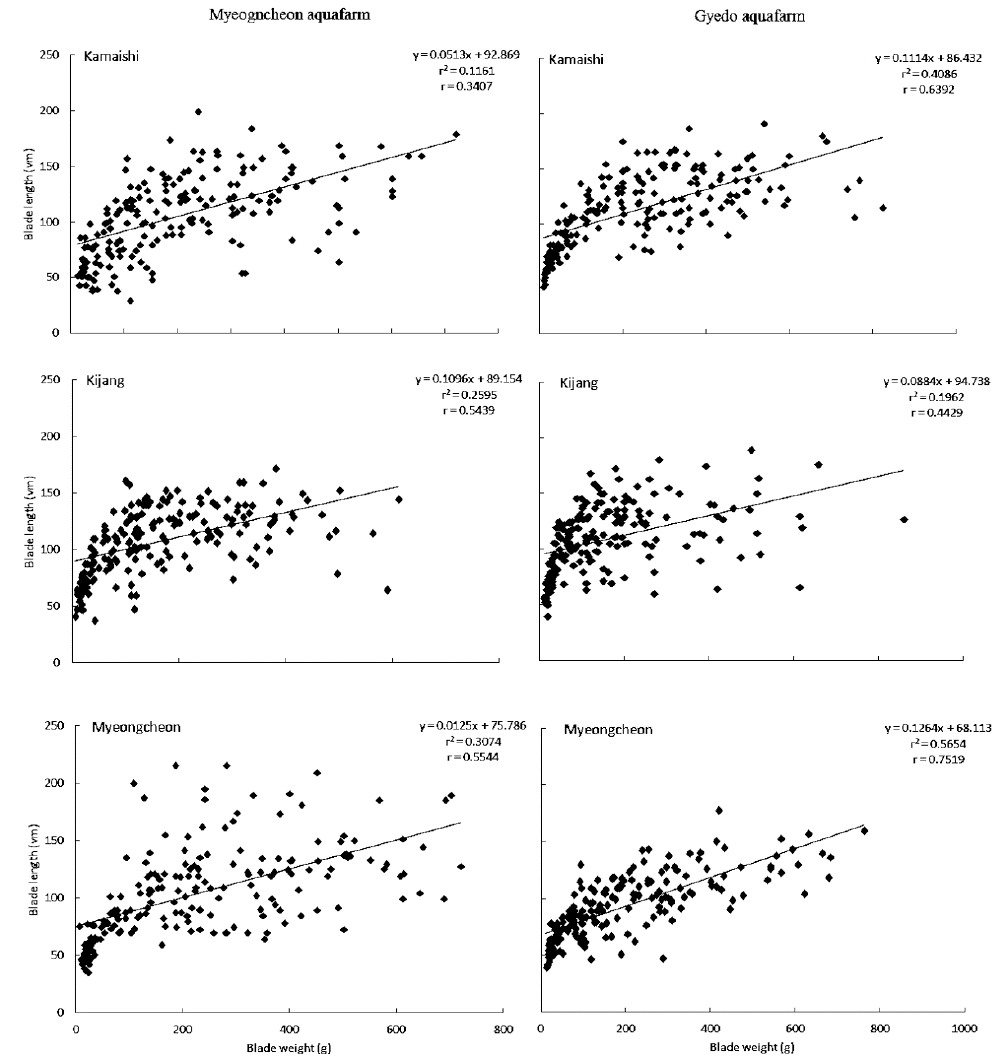
Figure 3. Relationships between blade weights and blade lengths of three U. pinnatifida cultivars at Myeongcheon and Gyedo aquafarms between January and May 2003.